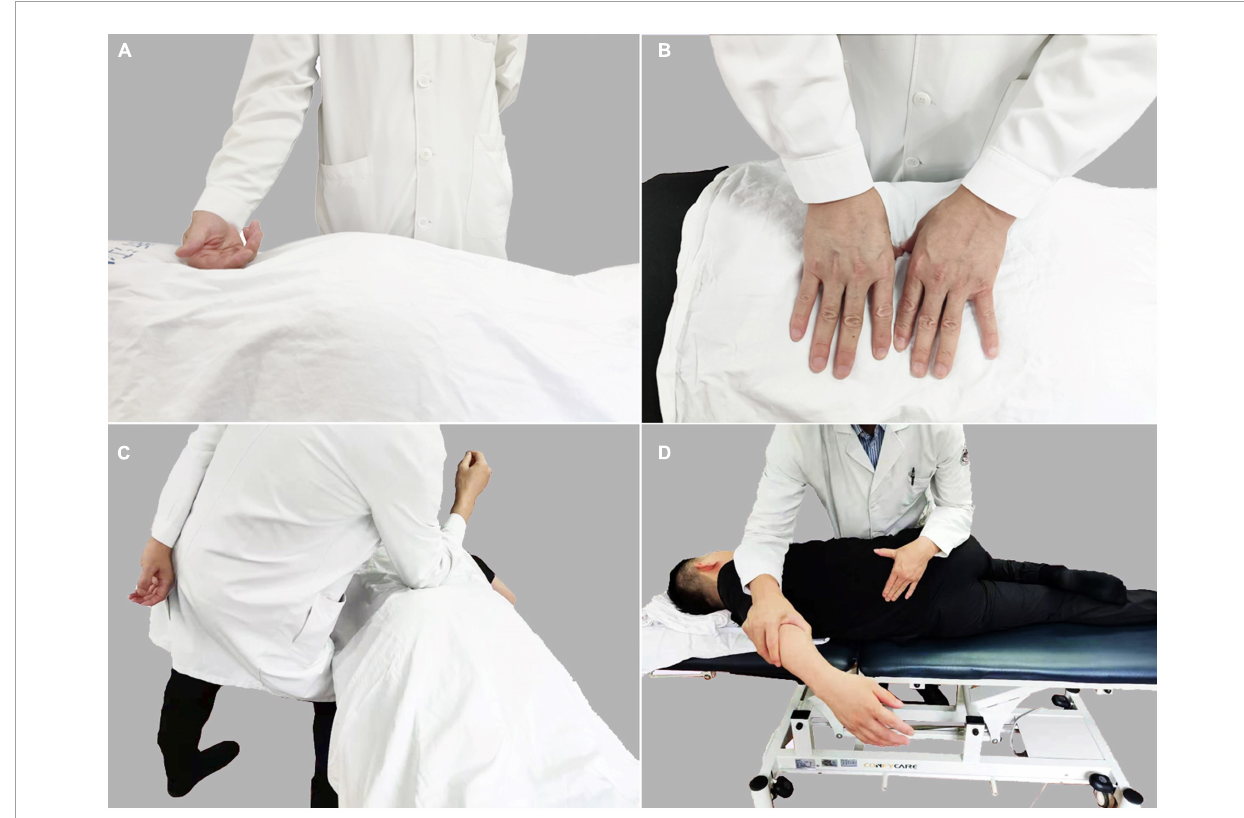
FIGURE1 Tuina performed by rolling (A) , kneading (B) , pushing (C) , and the pulling and rotating (D) to relax the muscles in the lower back area for the purpose of alleviating pain and improving lumbar